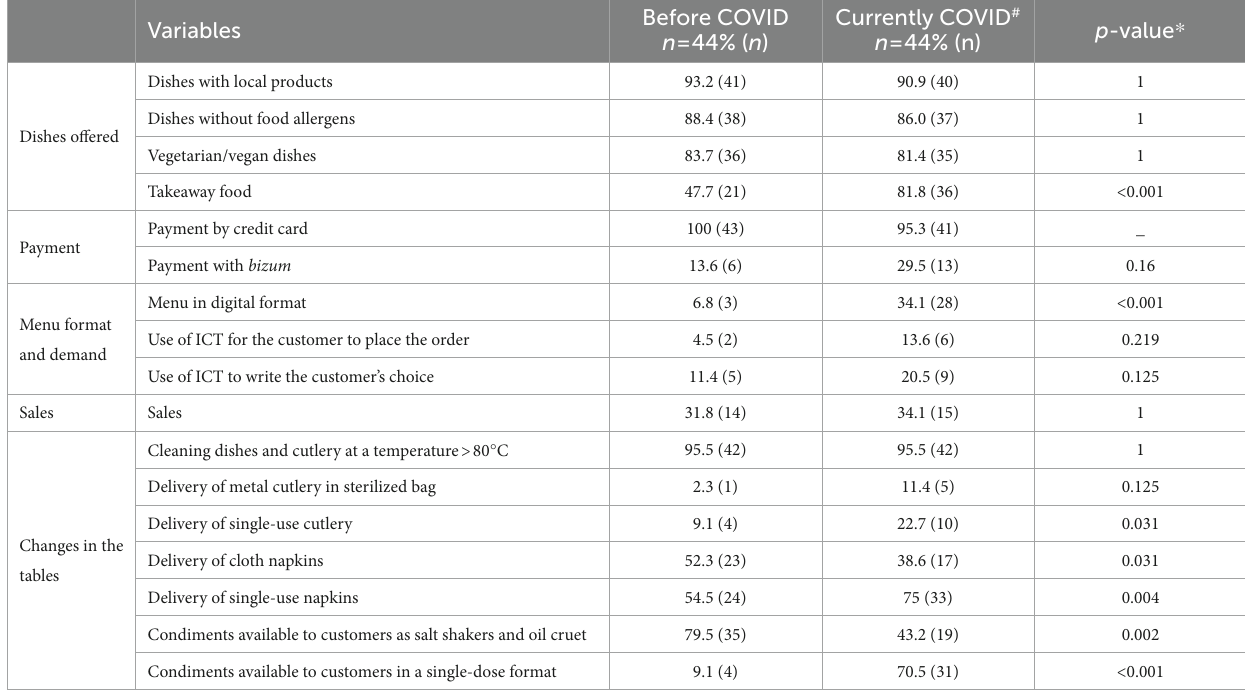
TABLE 1 Restaurants’ characteristics changes due to COVID-19.